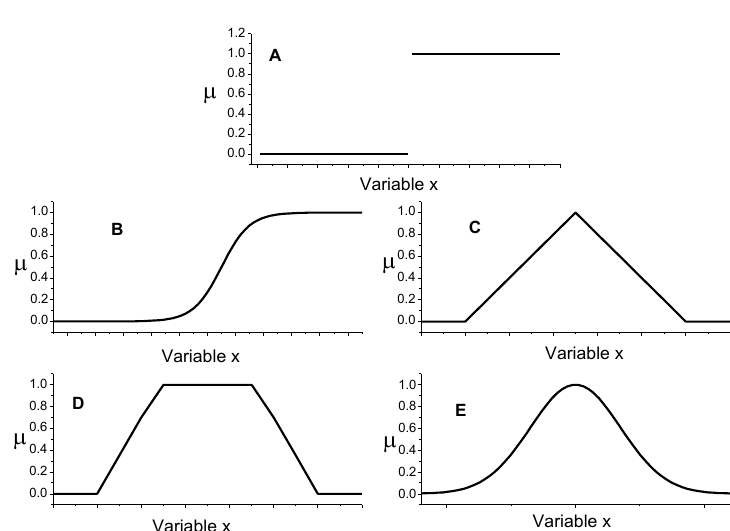
Figure 2. Shapes of the membership functions (μ) for a generic variable x: the case of a classical Boolean set in A ; examples of fuzzy sets with sigmoidal, triangular, trapezoidal, and Gaussian shapes are shown in B , C , D , and E plots, respectively.